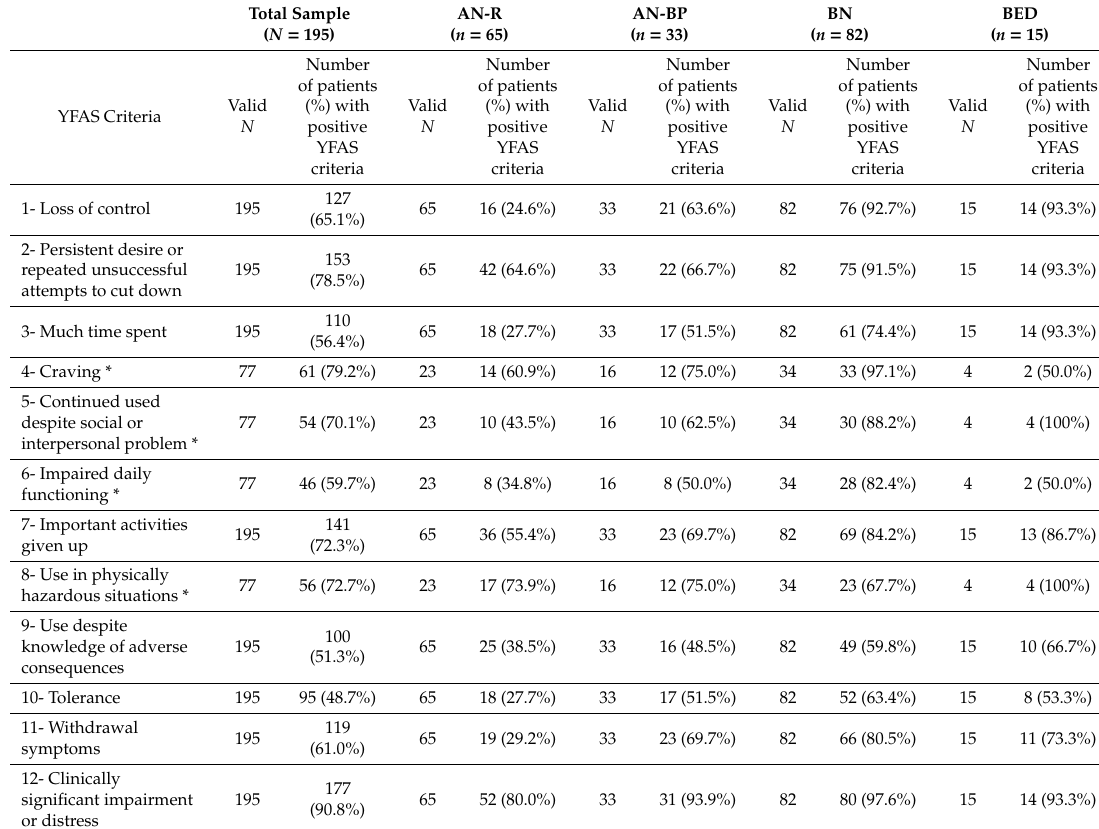
Table 4. Percentage of each YFAS criterion met for ED patients and according to the type of